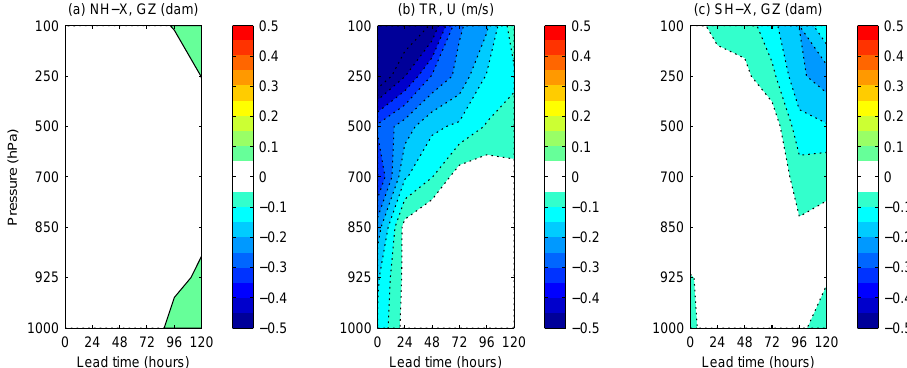
Fig. 8. Same as the previous figure, except for the July/August 2011 period.